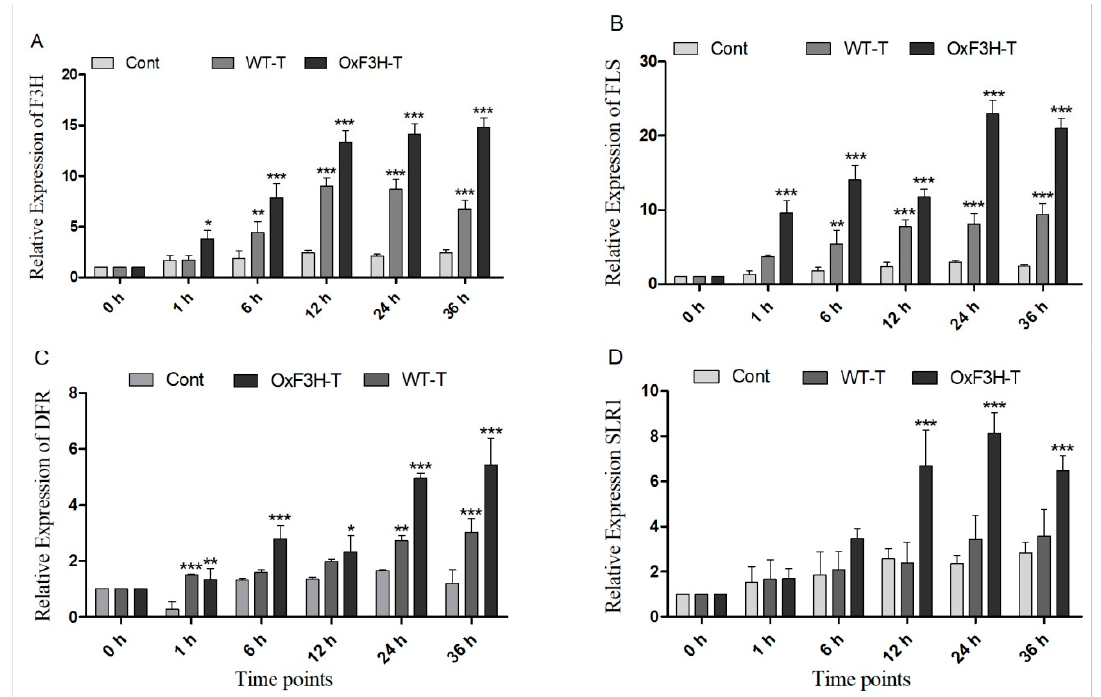
Figure 5. Relative expression patterns of F3H and related genes in the control, WT, and OxF3H plants. ( A – D ) F3H, FLS, DFR. and SLR1, respectively. The fold change of each gene was measured after each given time point and actin was used as the reference gene. Graph bars indicate mean ± standard deviation and * p ≤ 0.5, ** shows p ≤ 0.01 and *** shows p ≤ 0.001 significant difference, as analyzed using two-way ANOVA and a Bonferroni posttest.